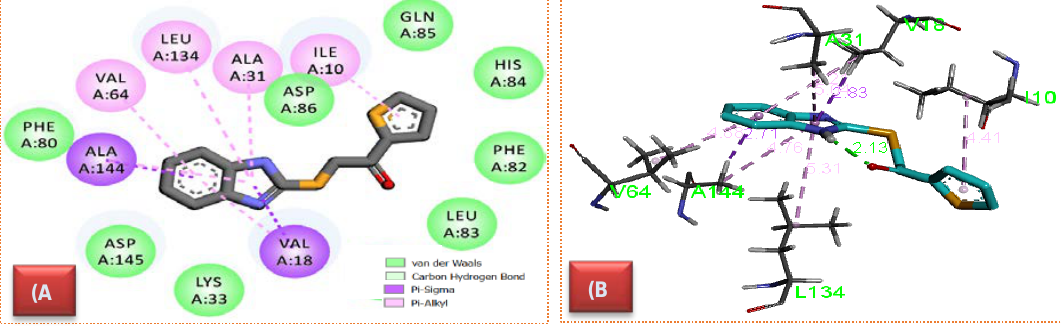
Figure 7. ( A ) 2D and ( B ) 3D diagram of benzimidazole 10f displaying its interaction within CDK2 kinase active site (distances in Å).